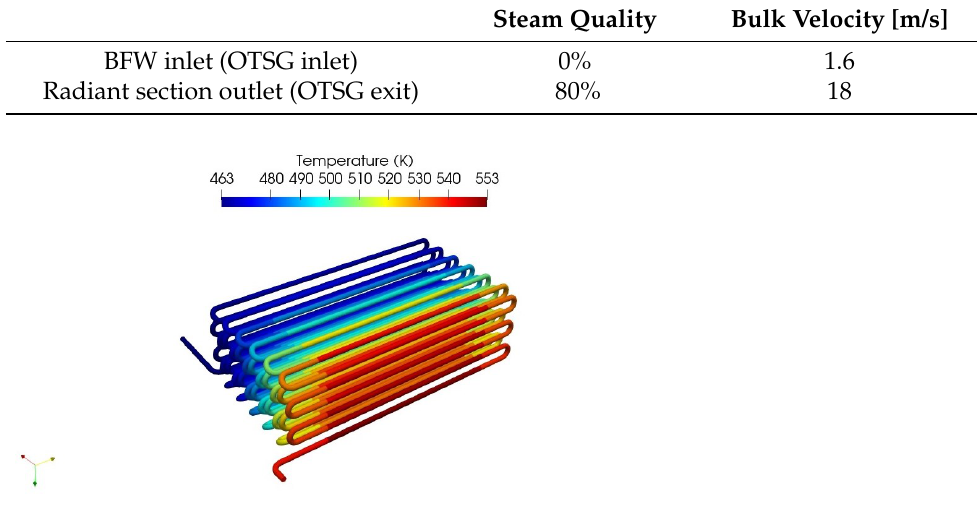
Figure 23. Temperature contours within Second Tubes in the convection box–whole